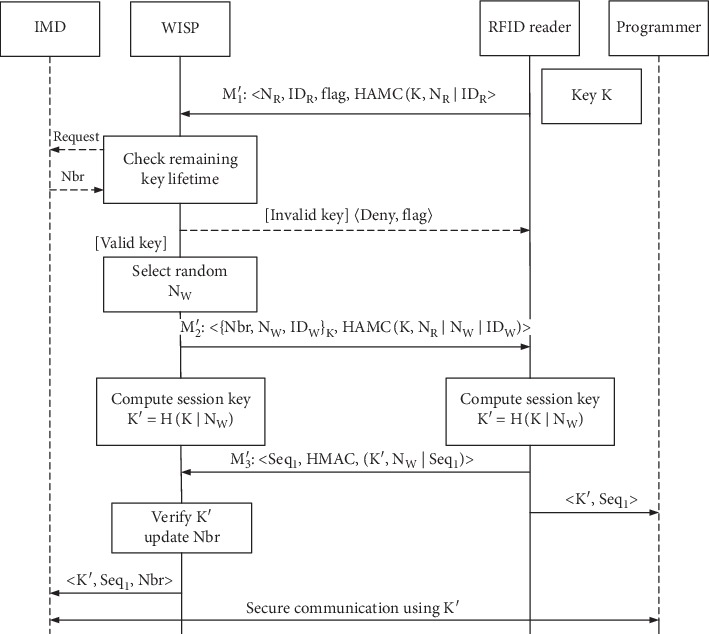
Mutual authentication in the regular mode (protocol 2).